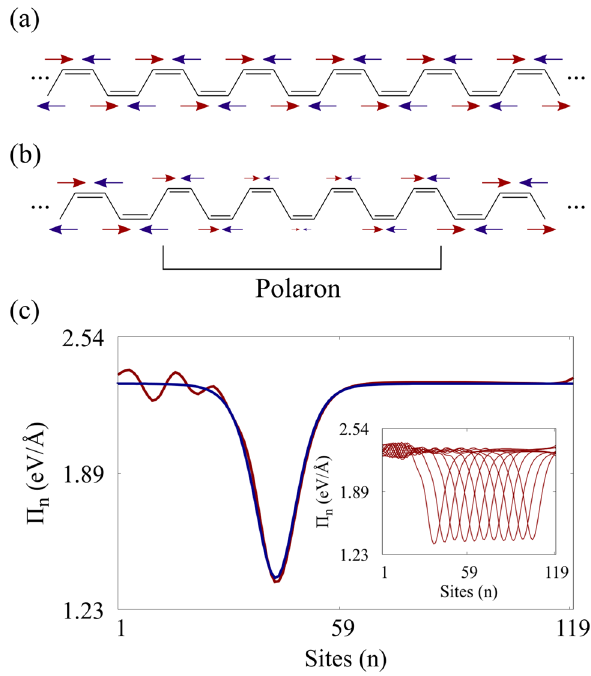
Figure 1. Diagrams (a) and (b) illustrate the behavior of the effective force field in two situations: (a) in the absence of quasiparticles and (b) when the chain hosts a polaron. At each site, there is a colored arrow that symbolizes the orientation of the force field caused by the π -electrons effective potential. The red color indicates odd parity, while the blue even. In (b), there is a distorted set of arrows representing the field distortion associated with the quasiparticle. In (c), the force fields, (cid:31) n , for the conventional and alternative approaches are shown. The lines in red refer to the conventional method, while the blue one is for the effective approach. The inset presents the effective field’s time evolution as the polaron drifts.